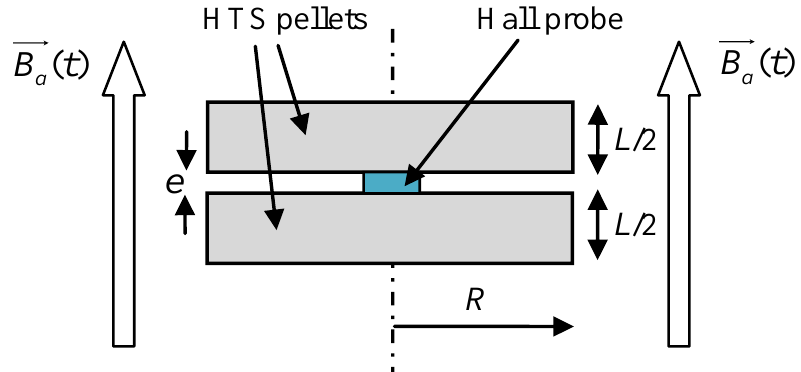
Figure 10. Hall probe location between two HTS bulks.